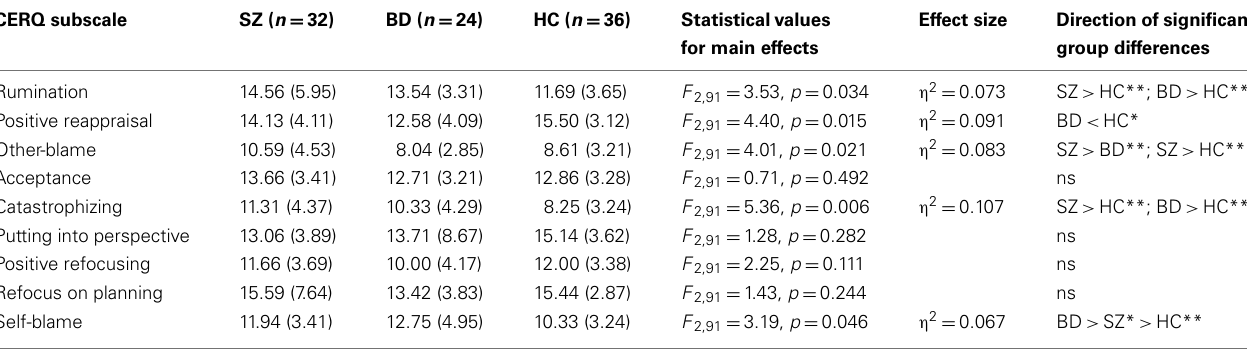
Table 3 | Means and SD for all groups on the